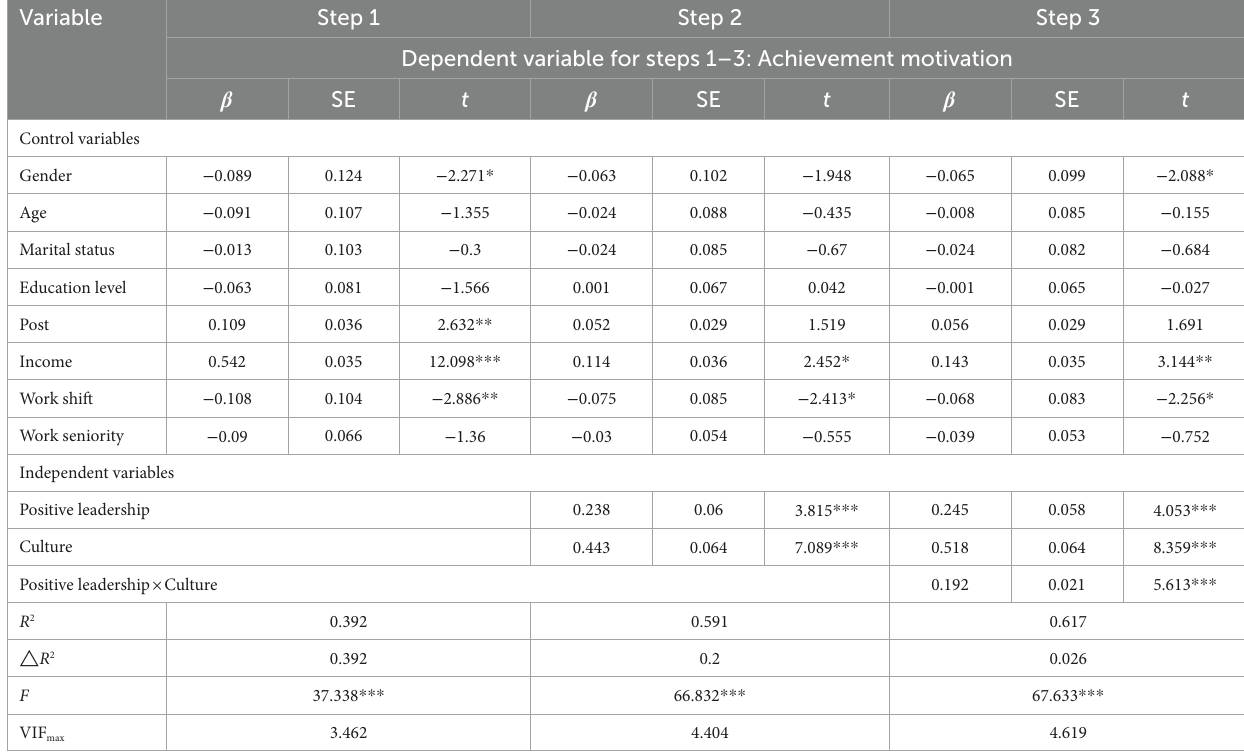
TABLE 7 Moderating effect of culture on the relationship between positive leadership and achievement motivation. Variable Step 1 Step 2 Step